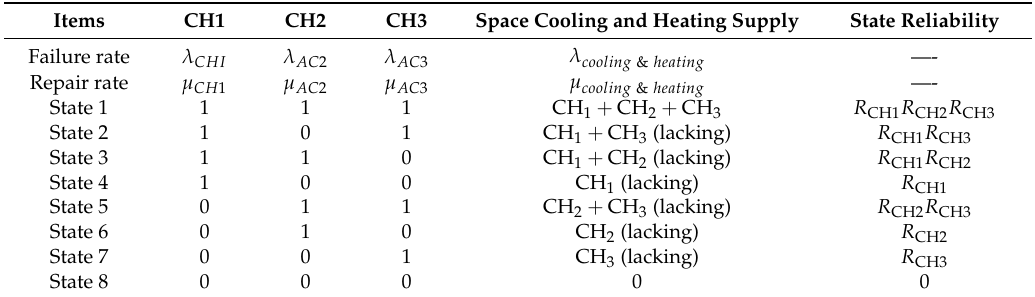
Table 8. The operation states and reliability data for the space cooling and heating subsystem of the CCHP